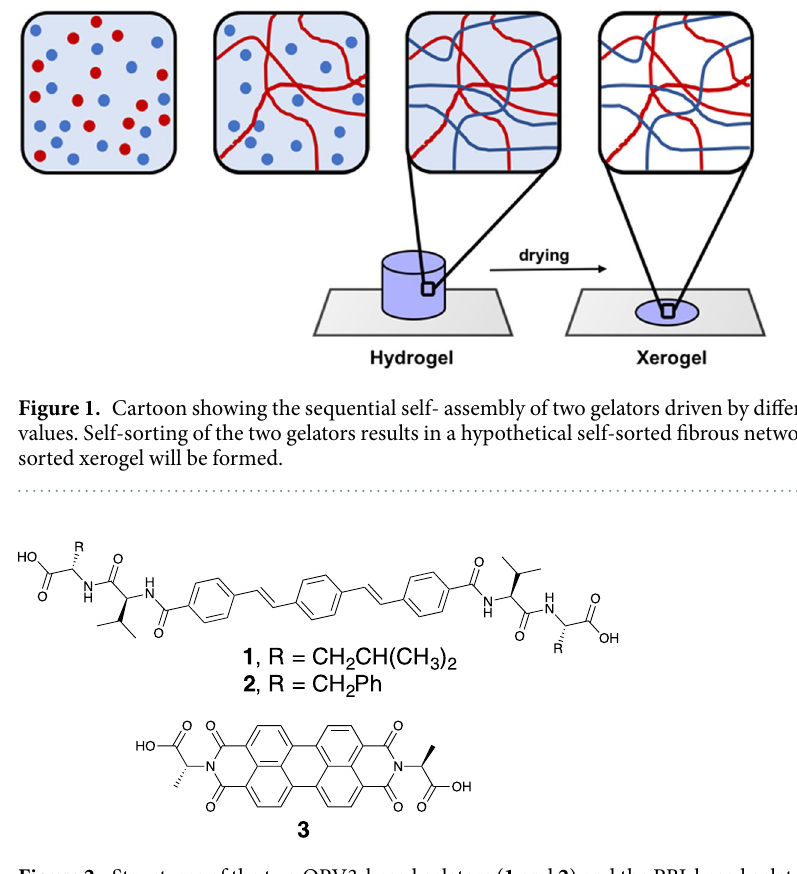
Figure 2. Structures of the two OPV3-based gelators ( 1 and 2 ) and the PBI-based gelator ( 3 ) used in this